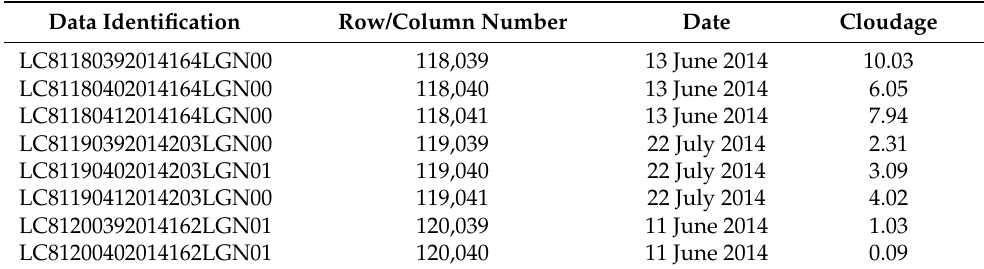
Table 1. Landsat 8 OLI image information of